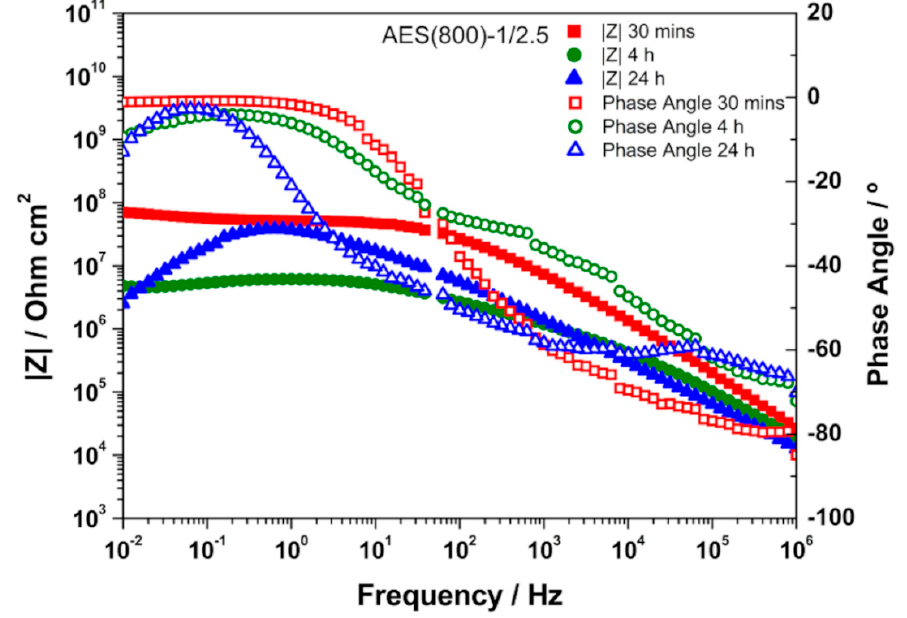
Figure 10. Bode plot for EIS analysis of AES(800)-1/2.5 after 30 min, 4 h and 24 h in SCPS.